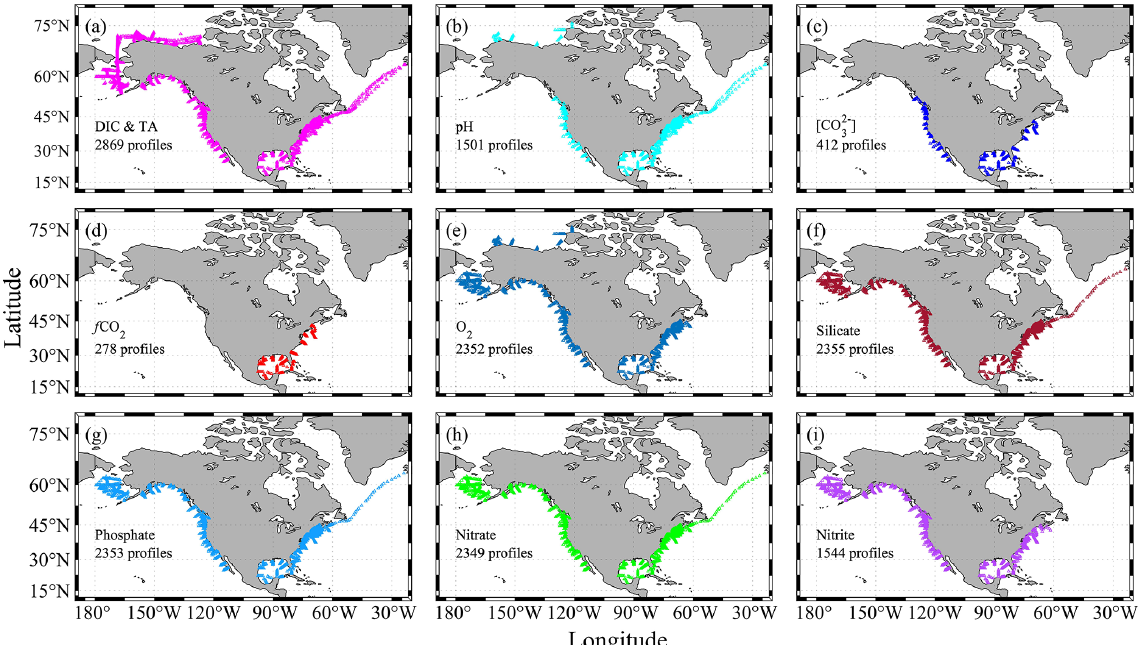
Figure 3. Sampling profiles for certain parameters. A profile is plotted if it has at least one measured value. Panel (a) only includes profiles that have both dissolved inorganic carbon (DIC) and total alkalinity (TA) measured. Panel (b) is for profiles with discrete pH measurements from a spectrophotometer. Panel (c) is for profiles with discrete carbonate ion content ([CO 2 − ]) measurements from a spectrophotometer. 3 Panel (d) is for profiles with discrete fugacity of carbon dioxide ( f CO 2 ) measurements from flasks. Panel (e) is for profiles with recom- mended_Oxygen values (see Table 1 for more details). Panels (f) – (i) are for profiles with nutrient